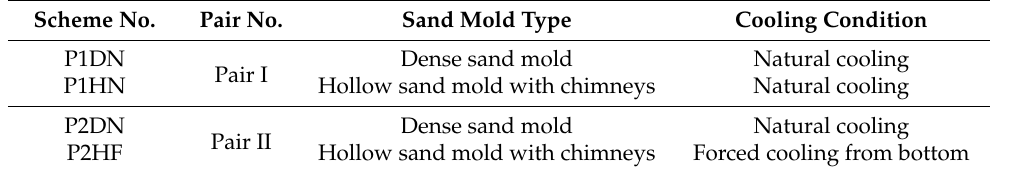
Table 4. Casting experiment